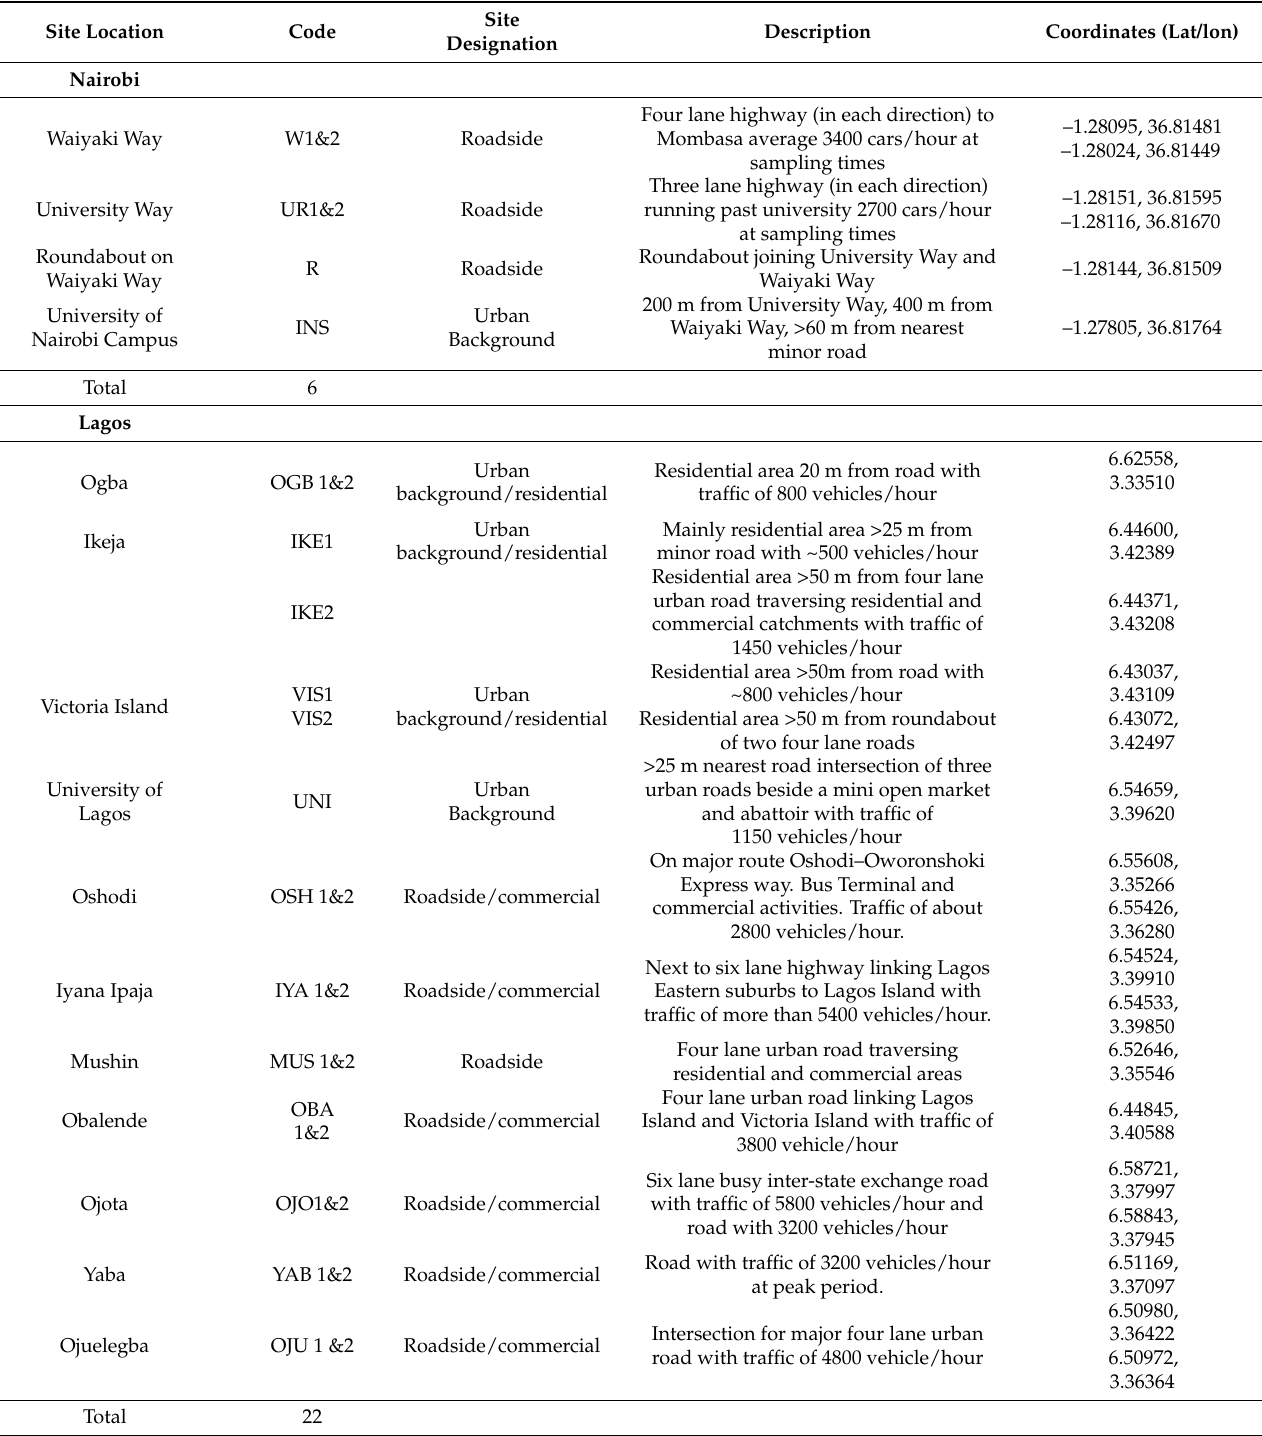
Table 1. Description and locations of sampling sites in Nairobi CBD, and